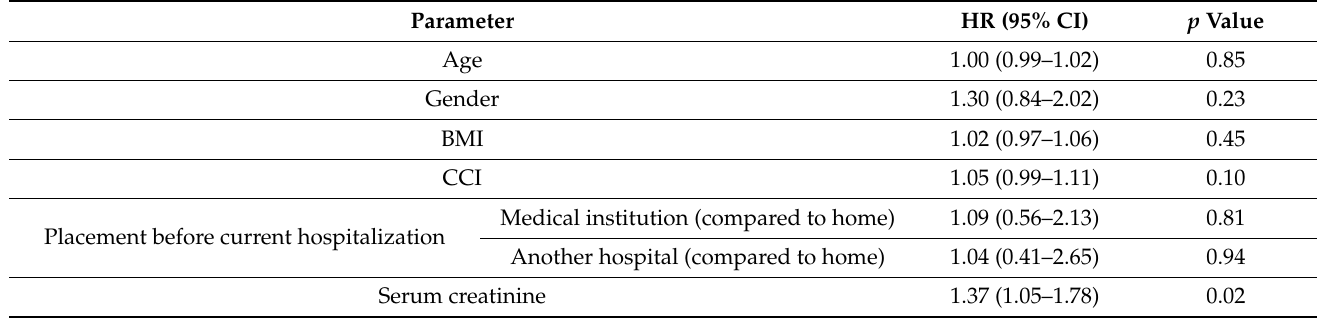
Table 2. Risk factors for re-admission according to a multi-variable analysis.